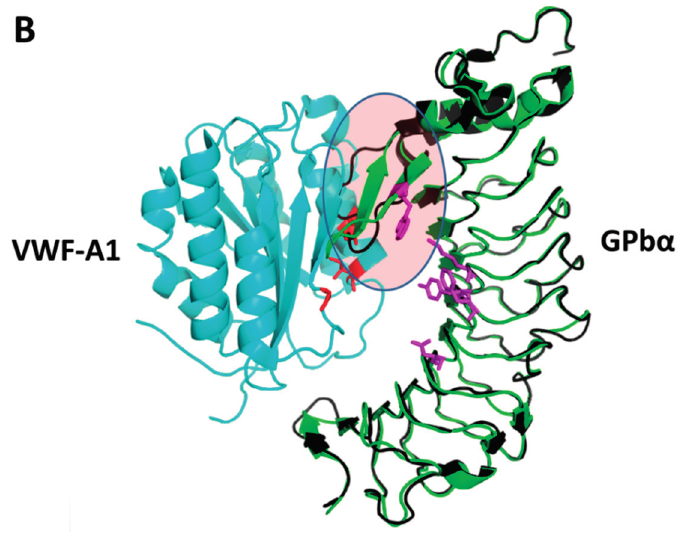
Figure 3. ( A ) Crystal structure of the complex of VWF-A1 and GPIb α (PDB ID: 1SQ0) [209] showing the hot spots determined by computational methods. Residues in the hot spot region of VWF-A1 are shown as red sticks. Residues from the hot spots of GPIb α are shown as sticks in magenta. Amino acids from VWF-A1 are labeled with three-letter codes and those from GPIb α are labeled with single-letter codes; ( B ) Crystal structure of the complex of VWF-A1 and GPIb α (PDB ID: 1SQ0) [209] overlapped with the unbound structure of GPIb α (PDB ID: 1P9A) (shown in black). Note the marked oval shape where there is a change in the conformation between the free and bound states of GPIb α .